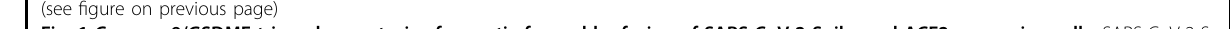
GSDME, especially in the small intestine and testis (Supplementary Fig. S7). The high-level expression of ACE2 and GSDME in testis could link to the destruction of male reproductive system by SARS-CoV-2 infection 14 . We analyzed single-cell-RNA-sequencing (scRNA-Seq) data from eight normal human lung transplant donors with a total of 42,225 cells 15 . As reported, the expression of ACE2 is concentrated in alveolar type 2 (AT2) cells, a special cell type with a small population in lung 16 and GSDME is also enriched in AT2 cells (Supplementary Fig.